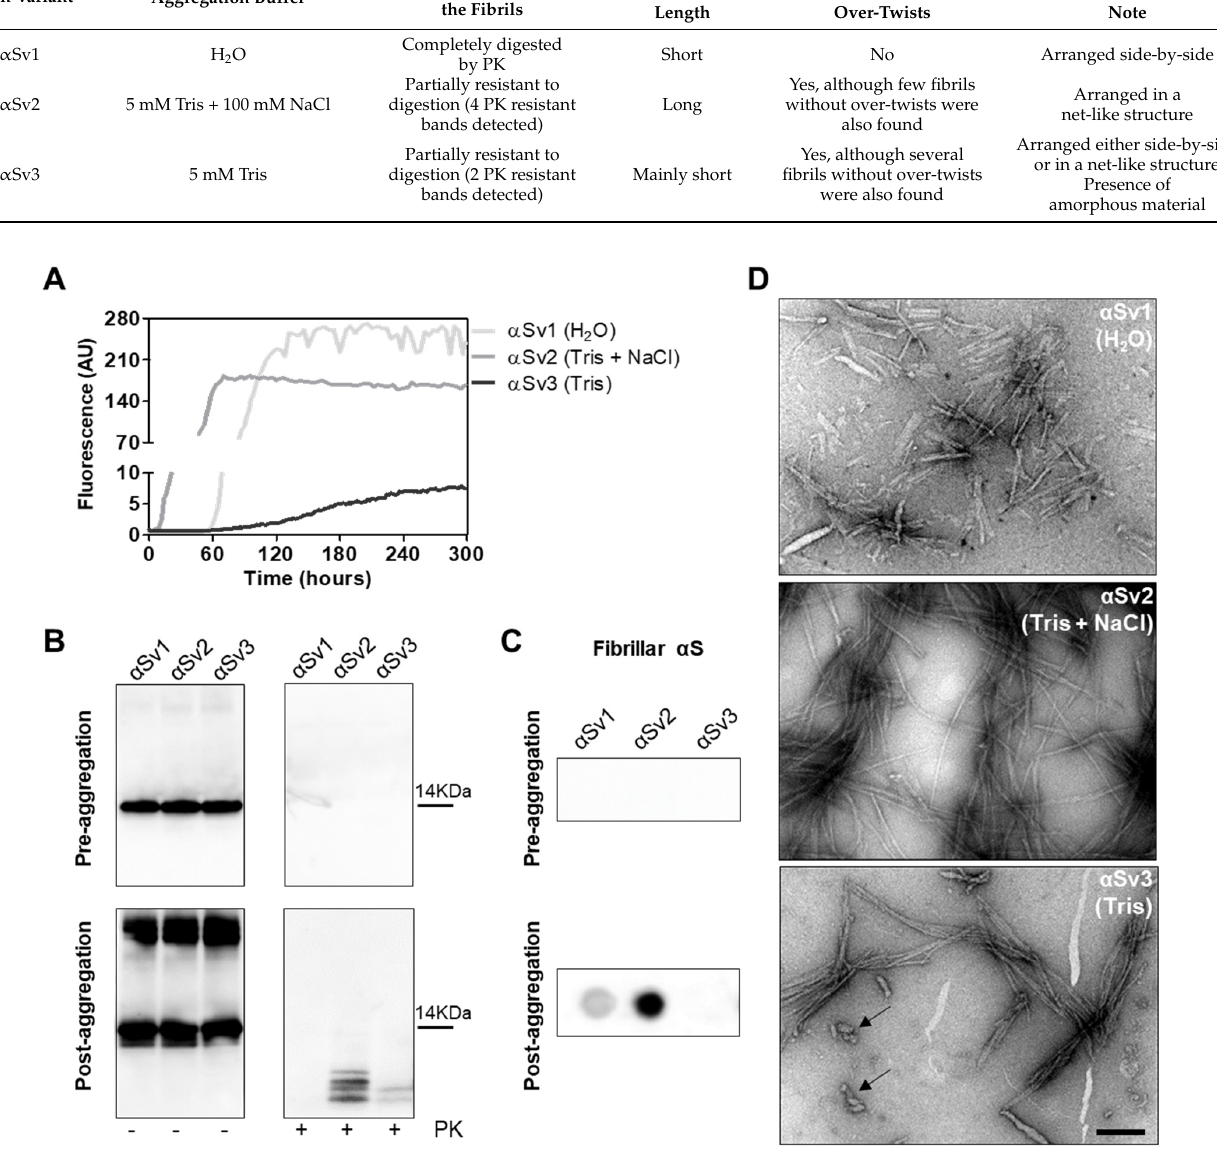
Figure 4. ( A ) Kinetics of α Sv1, α Sv2 and α Sv3 aggregation. Rec- α Syn was induced to aggregate in H 2 O ( α Sv1, light grey line), 5 mM Tris and 100 mM NaCl ( α Sv2, dark grey line) or 5 mM Tris ( α Sv3, black line), under continuous shaking, and the aggregation was monitored with the use of ThT. Curves represented in the graph were obtained by plotting the average fluorescence intensities of each sample against time. ( B ) Western blot analysis of untreated or PK digested α Sv1, α Sv2 and α Sv3. Before aggregation, the rec- α Syn was completely digested, regardless of the reaction buffer. After aggregation, α Sv1 was completely digested by PK, α Sv2 showed four PK-resistant bands while α Sv3 showed two PK-resistant bands. Samples were immunoblotted with the AS08 358 antibody. Number on the right indicates the molecular weight. ( C ) Dot blot analysis of α Sv1, α Sv2 and α Sv3 using MJFR antibody. As expected, before aggregation, MJFR did not recognize α Syn fibrils. After aggregation, α Sv1 and α Sv2 fibrils were recognized by MJFR (although with different affinity) while α Sv3 fibrils did not. ( D ) TEM analysis of α Sv1, α Sv2 and α Sv3. TEM analysis showed that α Sv1, α Sv2 and α Sv3 possessed different morphological features. Arrows indicate amorphous material found together with α Sv3 fibrils. Scale bar = 200 nm.